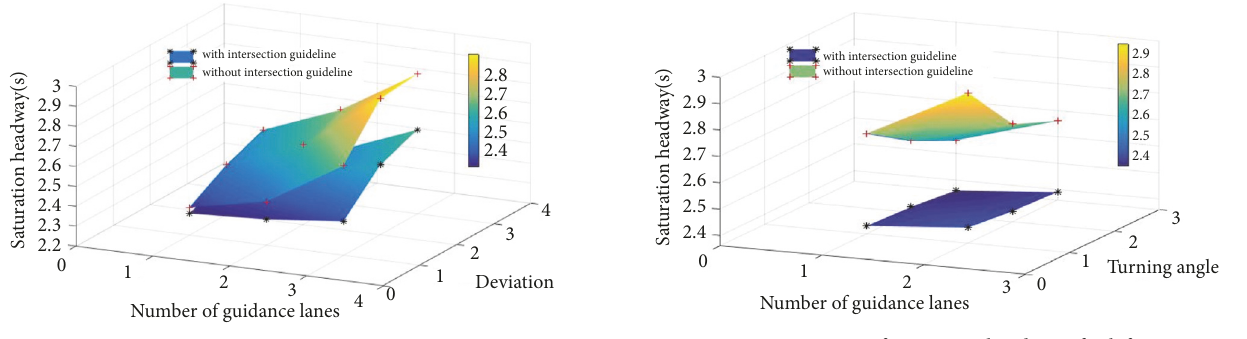
Figure 7: Comparison of saturation headways for through move- ment.